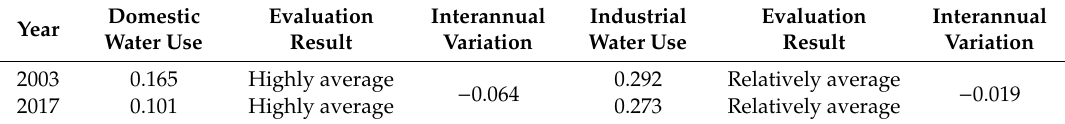
Figure 7. Lorenz Curve of domestic water use–urban population ( a ) and of industrial water use–secondary industry output ( b ) in Shandong in 2003 and 2017. Table 9. Gini index of industrial and domestic water use in Shandong in 2003 and 2017.